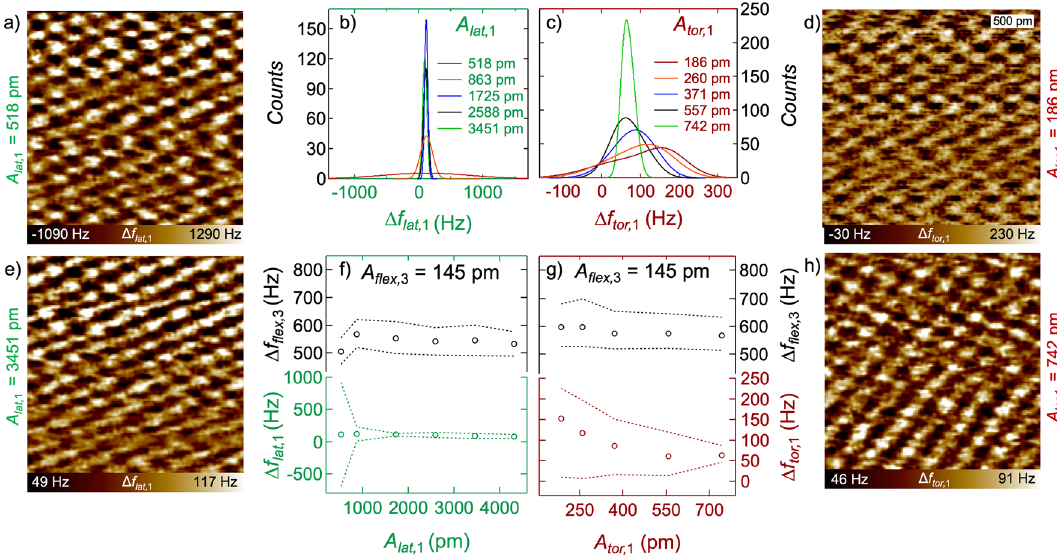
Figure 3. Influence of the lateral- and the torsional-amplitude setpoints on the frequency shifts in AMFlex2- FMLat1-FMFlex3 mode and in AMFlex2-FMTor1-FMFlex3 mode respectively. Frequency-shift images are shown exemplarily taken at A lat, 1 = 518 pm in ( a ), A lat, 1 = 3451 pm in ( e ) and A tor, 1 = 158 pm in ( d ), A tor, 1 = 628 pm in ( h ). Histograms of lateral ( b ) and torsional frequency-shift images ( c ) at different lateral-/torsional-amplitude setpoints. Third-eigenmode flexural and lateral ( f )/torsional ( g ) frequency shifts at maximum counts (open circles) and at FWHM (dotted lines) as a function of the lateral-/torsional-amplitude setpoints at a constant